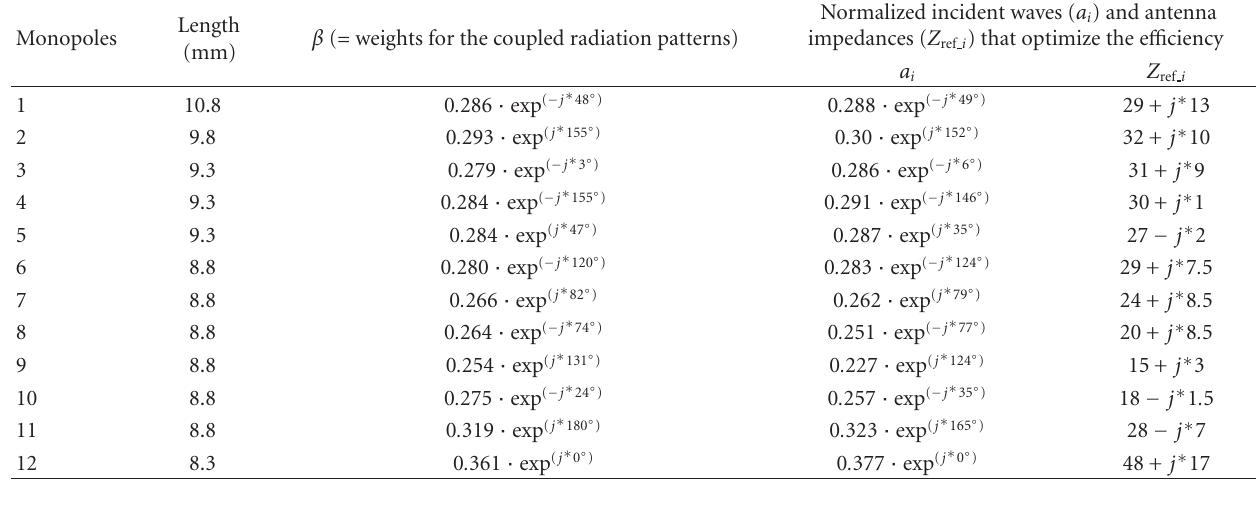
Table 1: Normalized incident waves and reference impedances which optimize the e ffi ciency of the array antenna for a specified radiation pattern (5.6GHz).